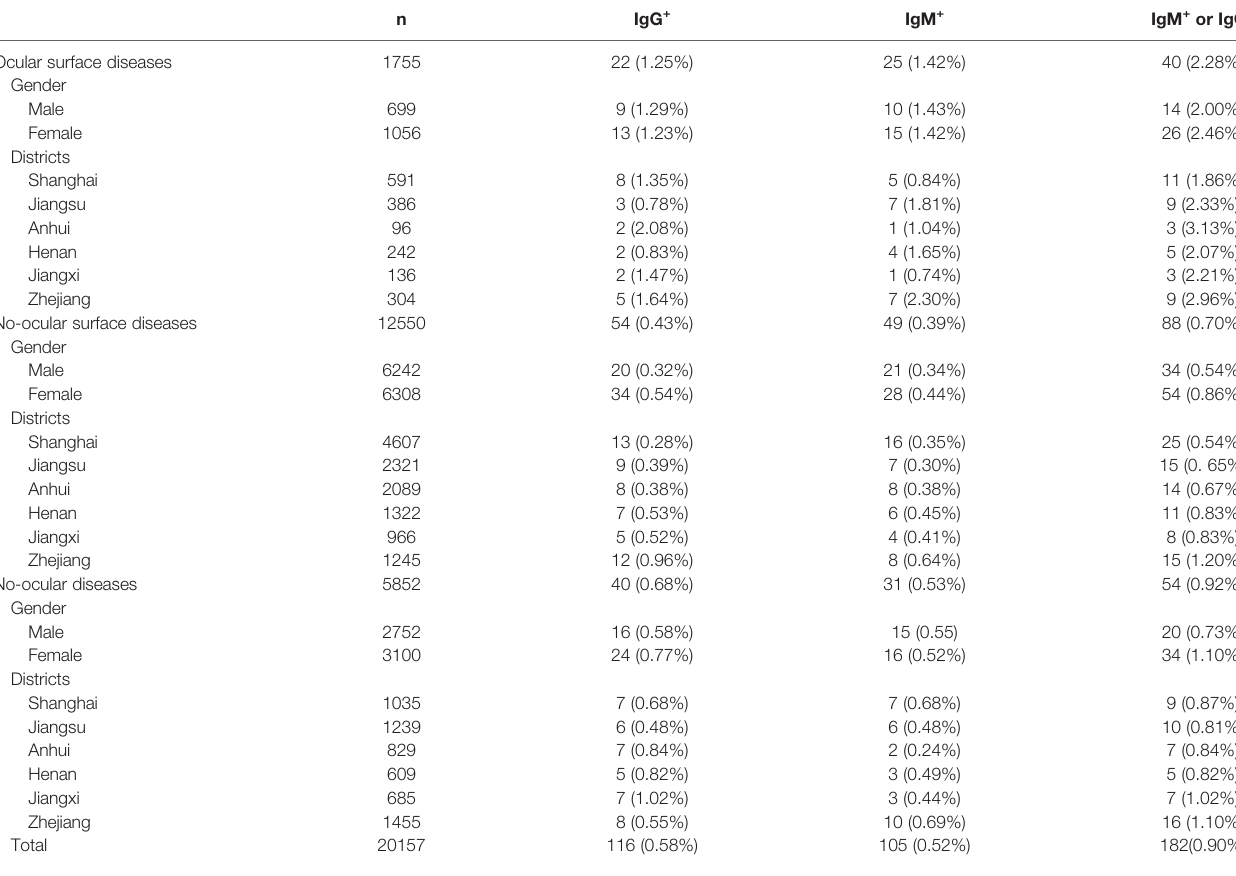
TABLE 2 | SARS-CoV-2 seroprevalence by sex and districts.